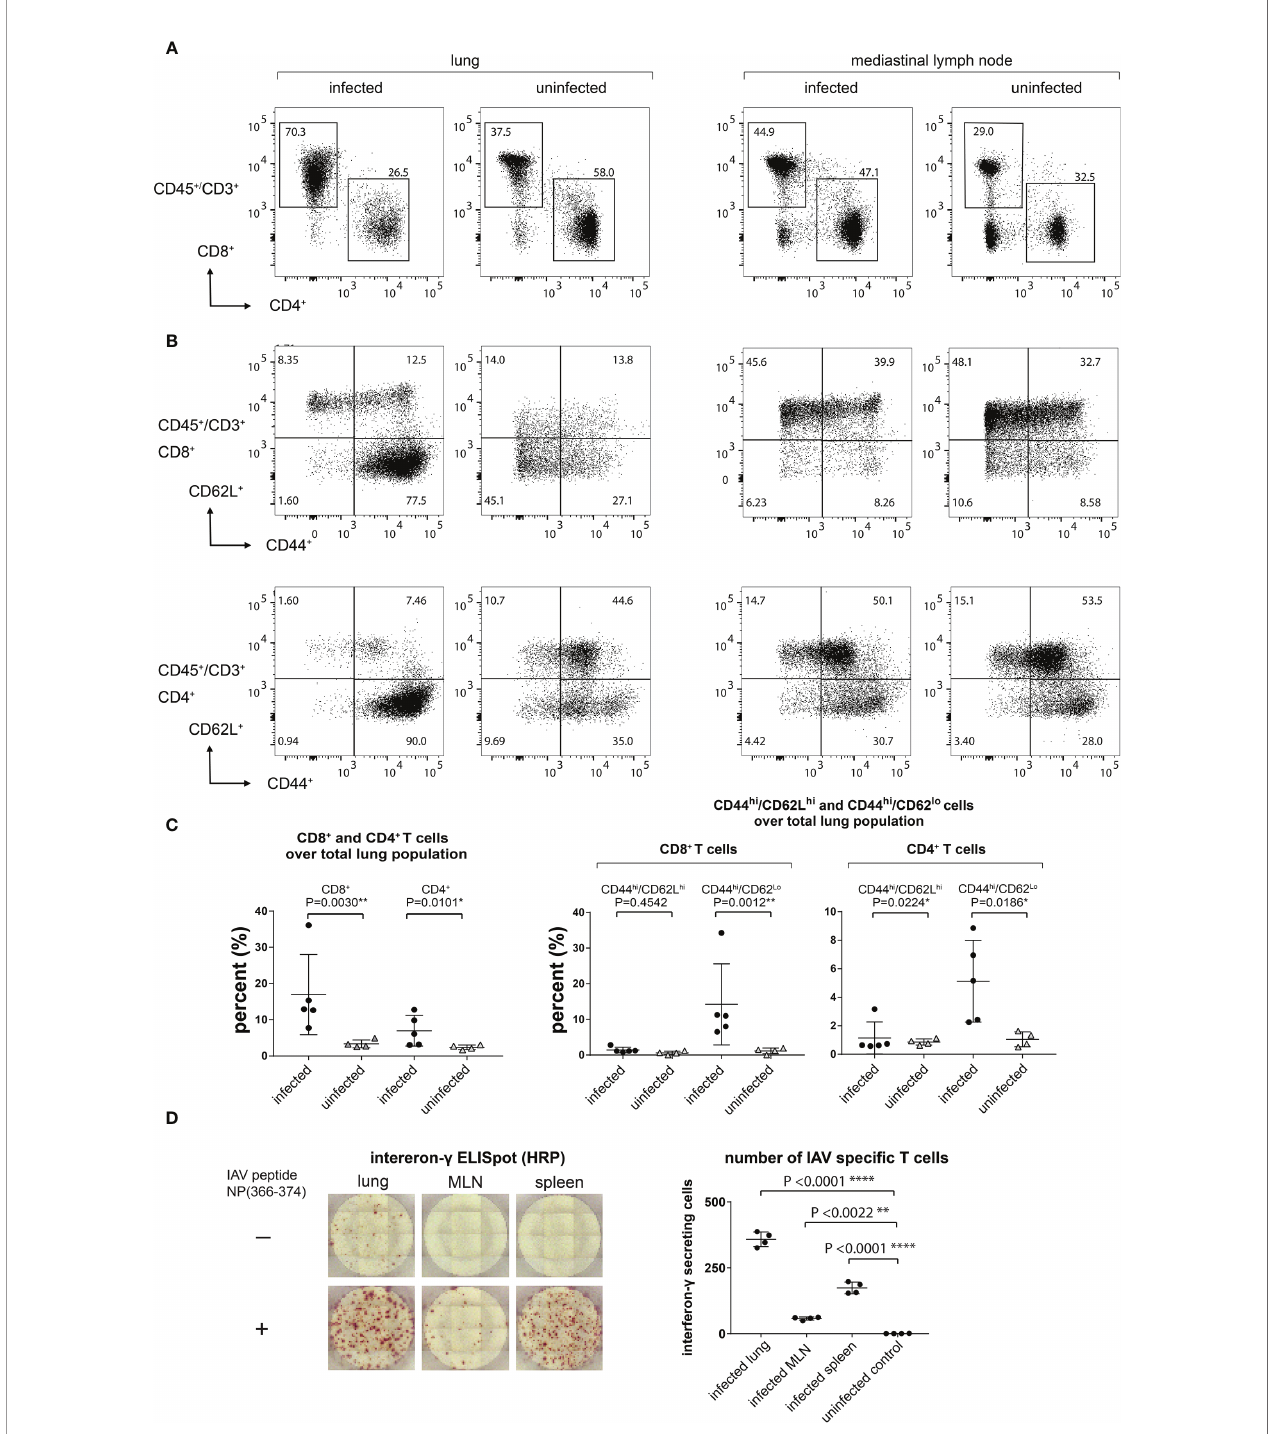
FIGURE 4 | Lung-In fi ltrating Cells are Predominantly CD8 + T EFF /T EM Cells, a Signi fi cant Amount of Which are IAV Speci fi c. (A) The in fi ltrating T cells were gated on CD45 + CD3 + and the ratio of CD4 + and CD8 + was determined. (B) CD8 + and CD4 + T EFF /T EM (CD44 hi CD62L lo ) and T CM (CD44 hi CD62L hi ) were gated on CD45 + CD3 + CD4 + CD44 + CD62L - and CD45 + CD3 + CD8 + CD44 + CD62L + . (C) Statistical analysis of data from (A, B) . (D) IAV-speci fi c T cell responses in lungs, MLN, and spleen as determined by an ELISpot assay. Representative ELISpot wells are shown in the left panel and statistical analyses of lungs, MLN, and spleen IAV- speci fi c T cells are shown in the right